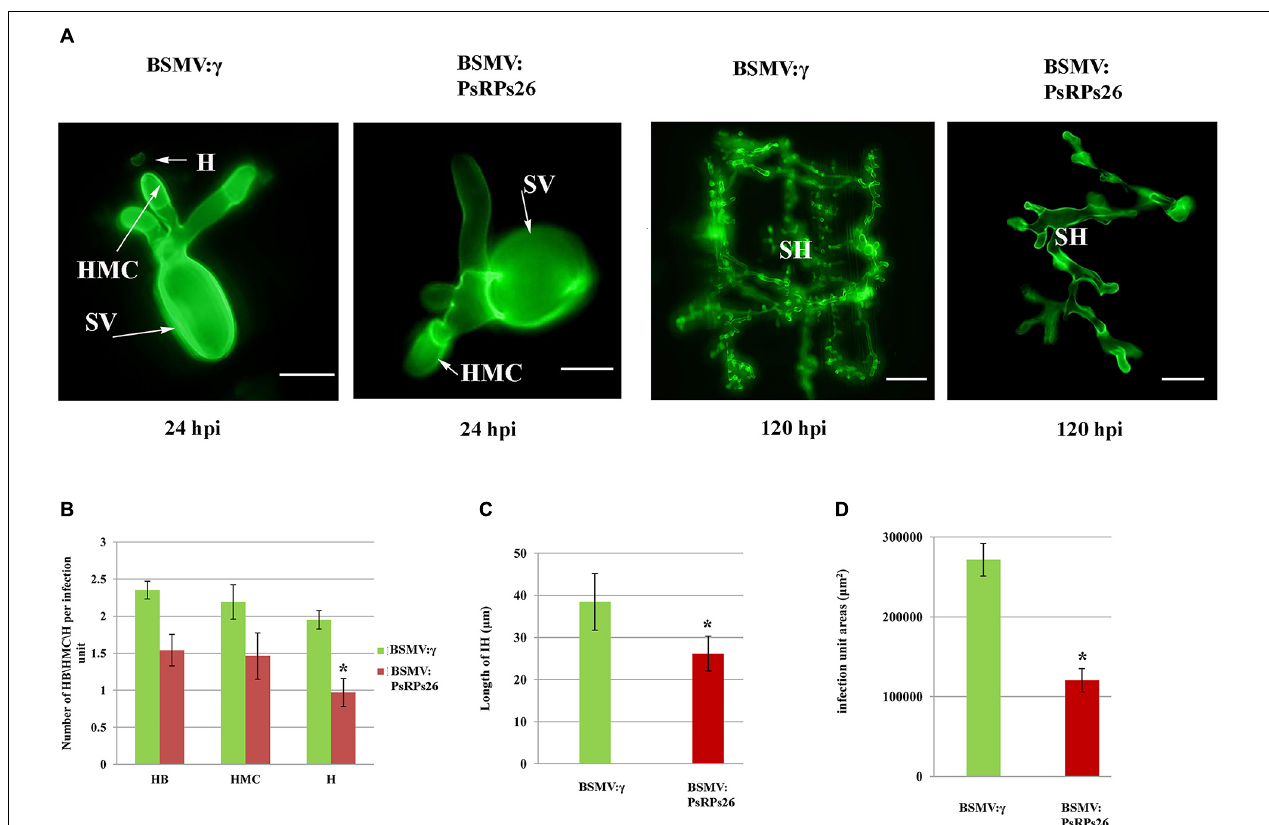
FIGURE 5 | Histological determination of fungal growth in host cells. (A) Cytological observation of fungal development in PsRPs26 knockdown wheat leaves inoculated with the Pst CYR31 race. Leaves were sampled at 24 and 120 hpi with the CYR31 isolate. (B) The number of haustoria was significantly reduced in the PsRPs26 -silenced plants at 24 hpi with the CYR31 isolate. (C) Significant decrease in the length of the infection hyphae in the PsRPs26 -silenced plants at 48 hpi with the CYR31 isolate. (D) PsRPs26 -silenced plants show a significant decrease in infection unit area at 120 hpi. H, haustorium; SH, secondary hypha; HMC, haustorial mother cells; SV, substomatal vesicle (24 hpi, bar = 20 µ m; 120 hpi, bar = 100 µ m). Significant differences were determined using Student’s t -test: ∗ P <